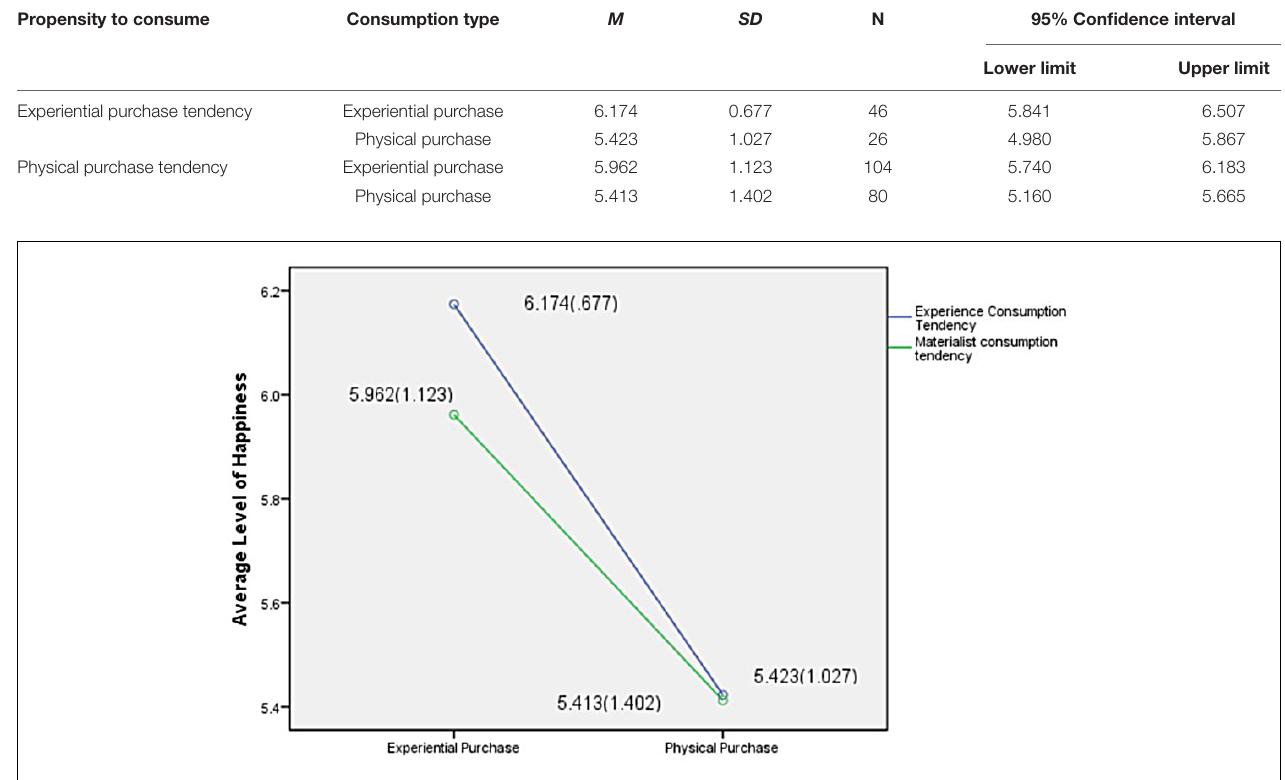
TABLE 3 | Descriptive statistics of the difference in happiness. Propensity to consume